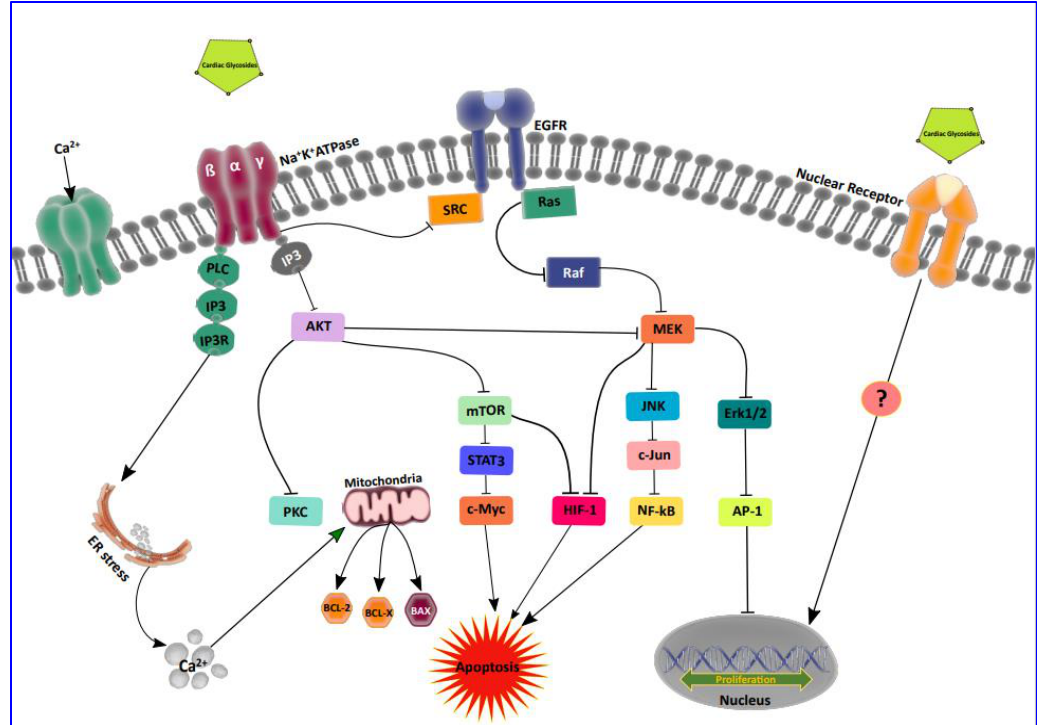
Figure 2. Illustrating the inhibition of transcription factors activated in cancer through cardiac glycosides. The binding of CGs on the Na + /K + /ATPase (NKA) channel decreases the NKA pump activity and thus down regulates multiple signal transduction cascades especially targeting the TF proteins involved in the cell growth and cell proliferation by providing signals to the transcription machinery. Dysregulated TF and their targeted therapy through CG are represented in the pathway. The scope of targeting nuclear receptors via CG is an upcoming purview to be studied for therapeutic